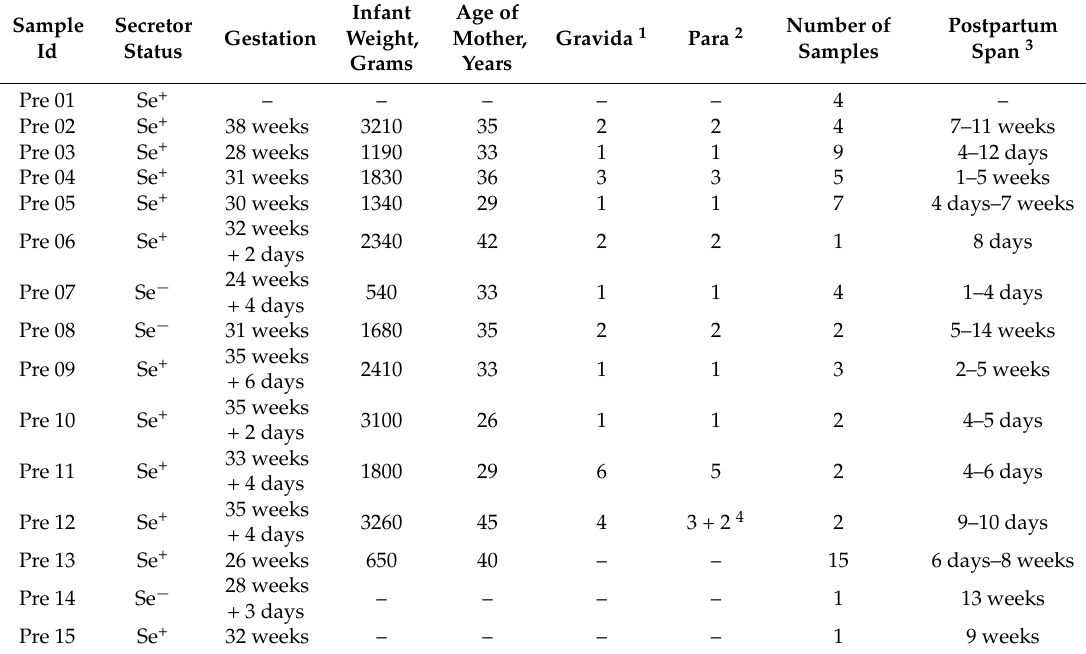
Table 1. Sample information from mothers of pre-term